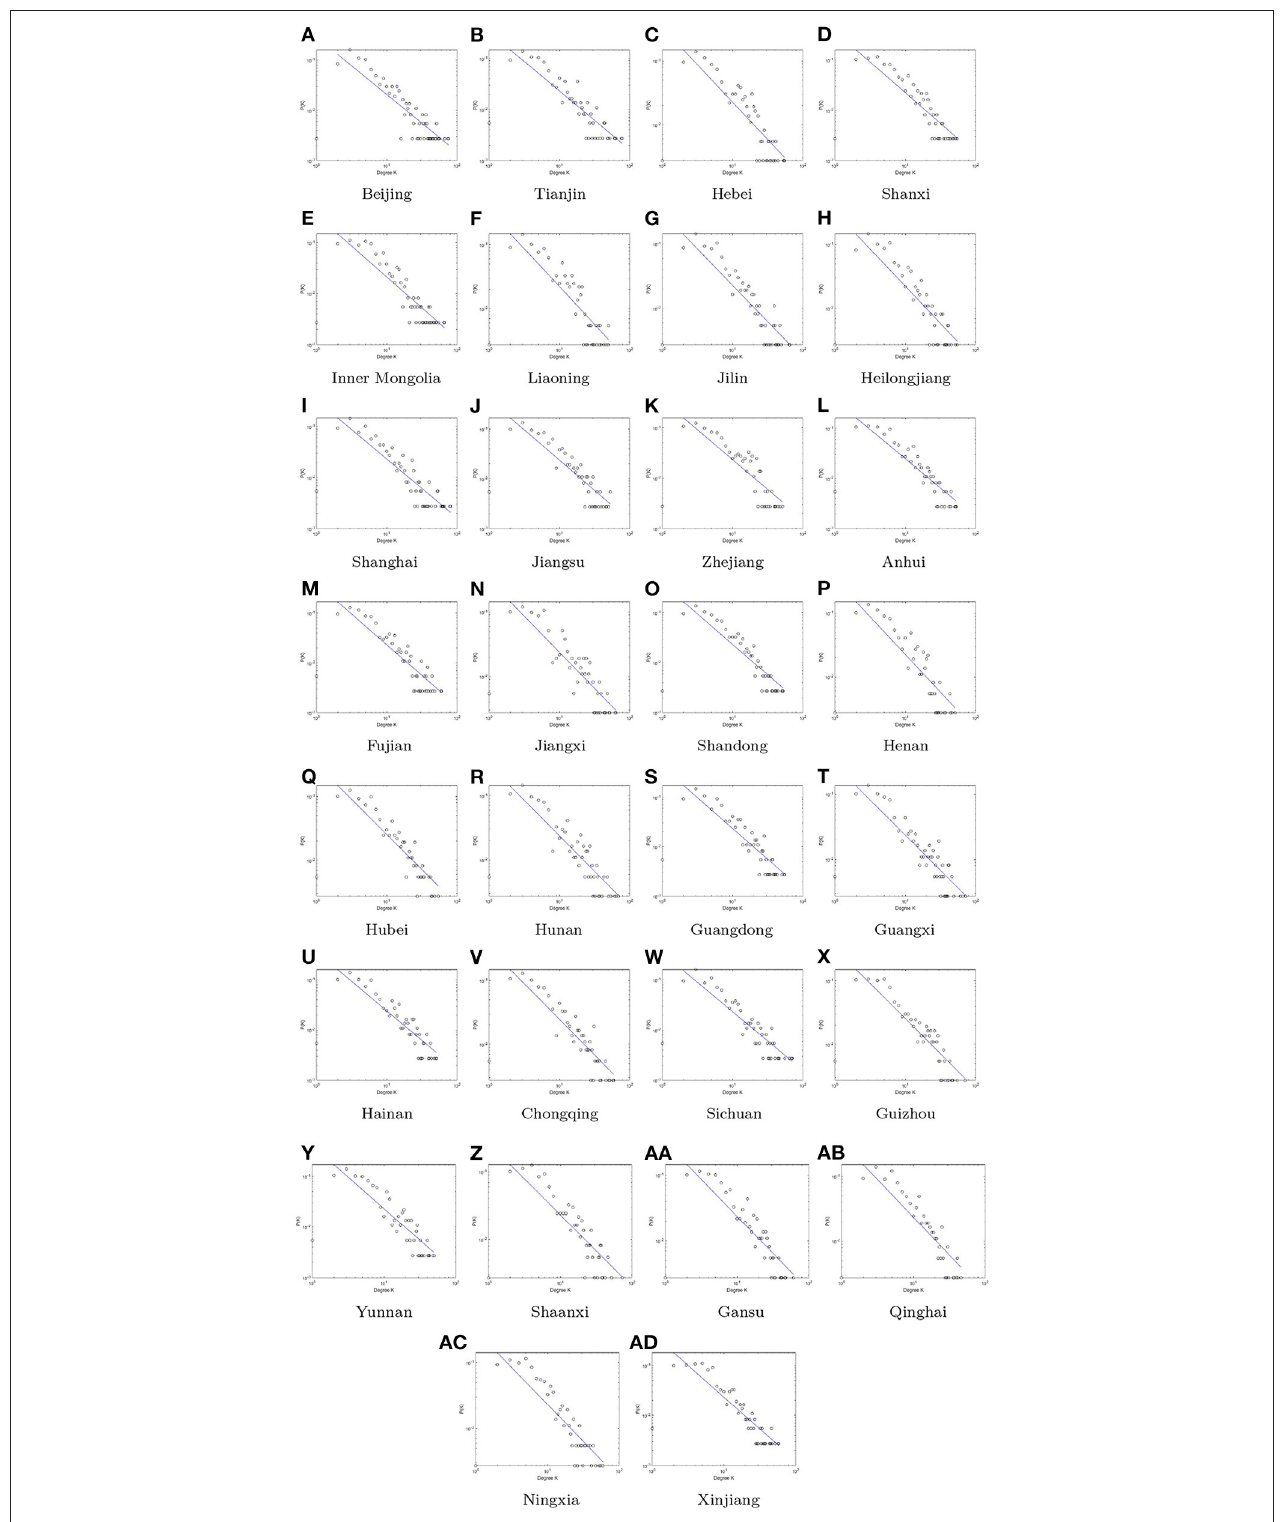
FIGURE 5 | The degree distribution of different provinces in China. (A) Beijing, (B) Tianjin, (C) Hebei, (D) Shanxi, (E) Inner Mongolia, (F) Liaoning, (G) Jilin, (H) Heilongjiang, (I) Shanghai, (J) Jiangsu, (K) Zhejiang, (L) Anhui, (M) Fujian, (N) Jiangxi, (O) Shandong, (P) Henan, (Q) Hubei, (R) Hunan, (S) Guangdong, (T) Guangxi, (U) Hainan, (V) Chongqing, (W) Sichuan, (X) Guizhou, (Y) Yunnan, (Z) Shaanxi, (AA) Gansu, (AB) Qinghai, (AC) Ningxia, and (AD) Xinjiang.